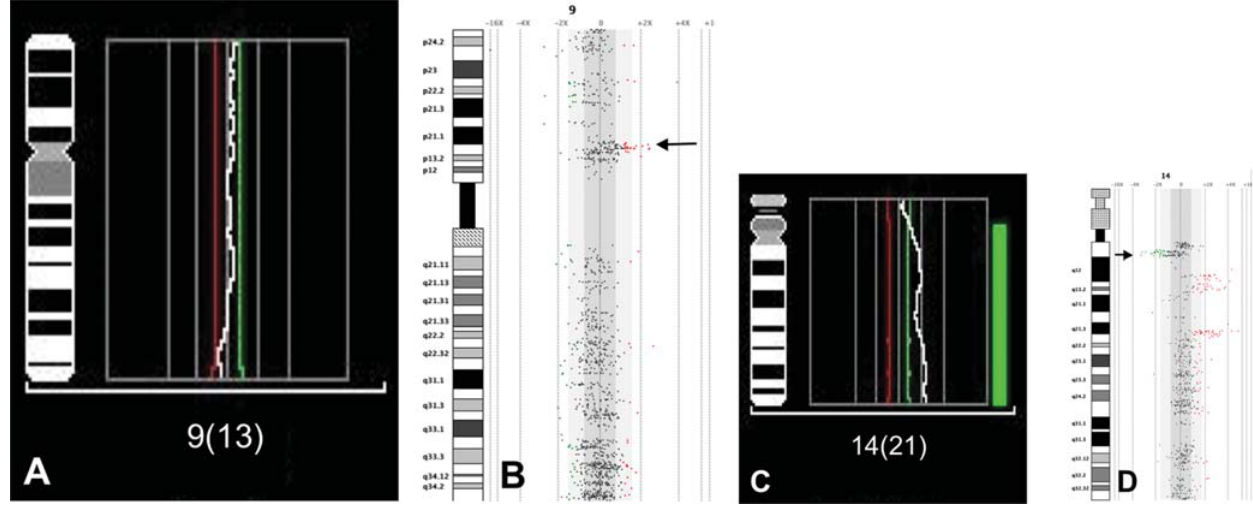
Figure 1. Comparison of cCGH (A, C) and arrayCGH (B, D) results from chromosome 9 of CWR22 and chromosome 14 of DU145-MN1. A small region of gain on 9p close to the centromer (B, arrowhead) and a small deletion on 14q (D, arrowhead) are only detected by arrayCGH.